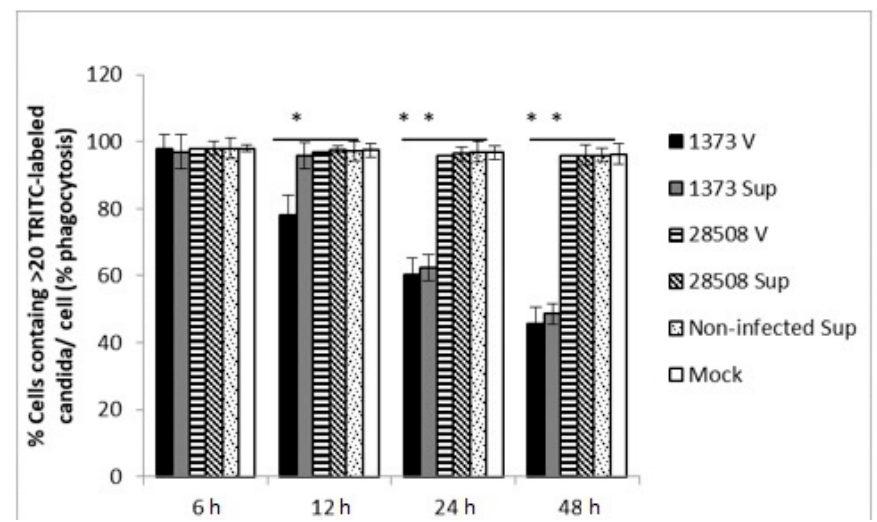
Figure 2. The effect of BVDV strains and the corresponding infected-MDM supernatants on macrophage phagocytic activity. Phagocytic index is defined as the % of MDMs that contains >20 TRITC-labeled C. albicans . h: hours post-treatment, V: direct virus infection, no supernatant, Sup: BVDV-infected macrophage supernatant, non-infected Sup: non-infected macrophage supernantant, Mock: culture medium *: p < 0.05 (>95% confidence), **: p < 0.01 (>99% confidence).